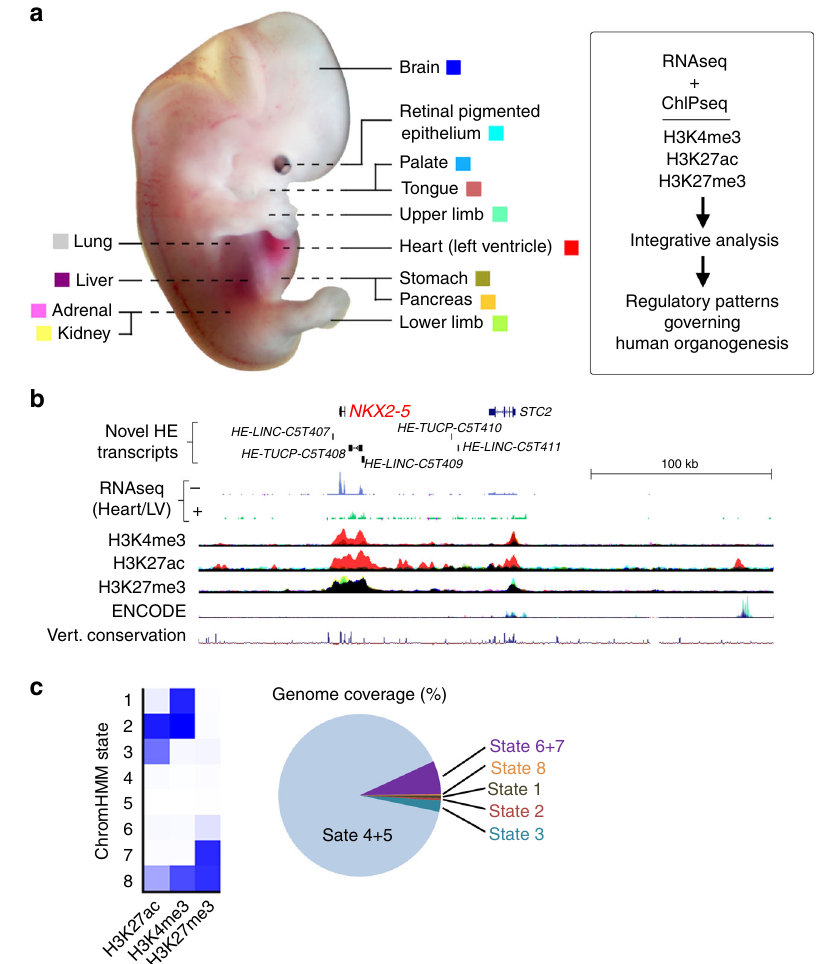
Fig. 1 Epigenomic landscape across 13 human embryonic tissues. a Thirteen different human embryonic sites were sampled for RNAseq 15 and ChIPseq, as described in the “ Methods ” and in Supplementary Data 1 and 2. The same colour coding for each tissue is applied throughout the paper in overlaid ChIPseq tracks. The heart (left ventricle) dataset is summarised as Heart/LV from hereon. b 300 kb locus around the NKX2-5 gene, the most discriminatory TF gene for human embryonic heart 15 . The locus contains fi ve unannotated human embryonic ( HE ) transcripts enriched in heart [three LINC RNAs and two transcripts of uncertain coding potential ( TUCP )]. Heart/LV-speci fi c (red) H3K4me3 and H3K27ac marks were detected at the NKX2-5 TSS and adjacent transcripts ( HE-TUCP-C5T408 and HE-LINC-C5T409 ). Embryonic heart-speci fi c H3K27ac marks were visible up to 200 kb away (e.g., at the extreme right of panel). H3K27me3 marked the region from NKX2-5 to HE-LINC-C5T409 in all non-heart tissues (the track appears black from the superimposition of all the different colours other than red). ENCODE data are from seven cell lines 26 . c Genome coverage by ChromHMM for the different histone modi fi cations was similar across all tissues (Supplementary Fig. 1) with an average 89.8% of the genome unmarked (range: 81.7 – 94.0; States 4 & 5), and 3.3% consistent with being an active promoter and/or enhancer (range: 1.7 – 6.1; States 1 –